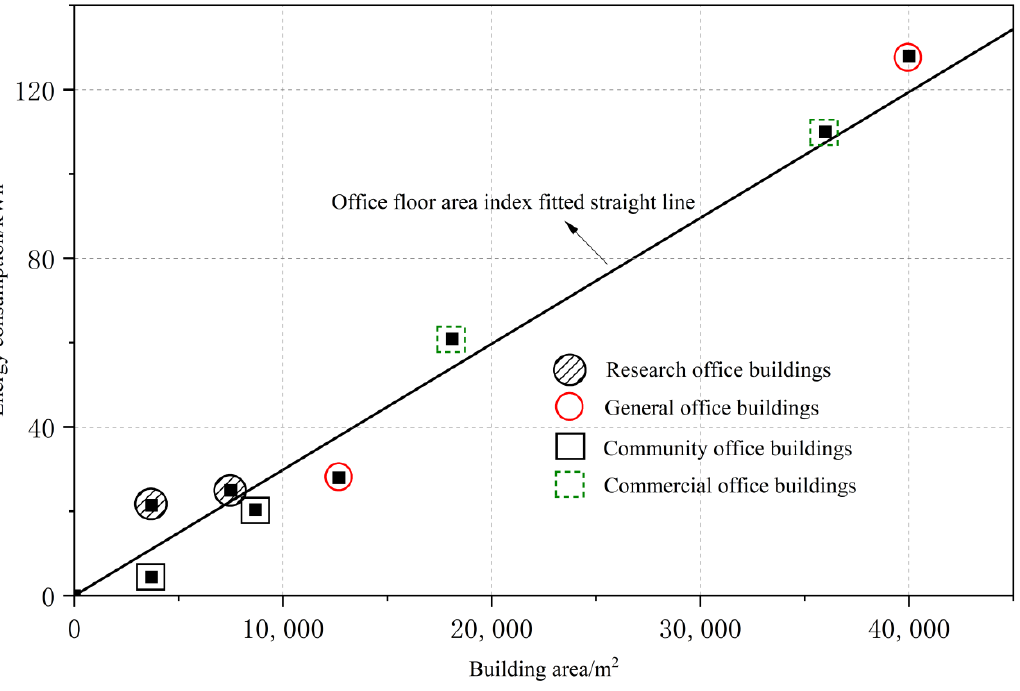
Figure 21. Correspondence between building area and base energy consumption for different types of office buildings.